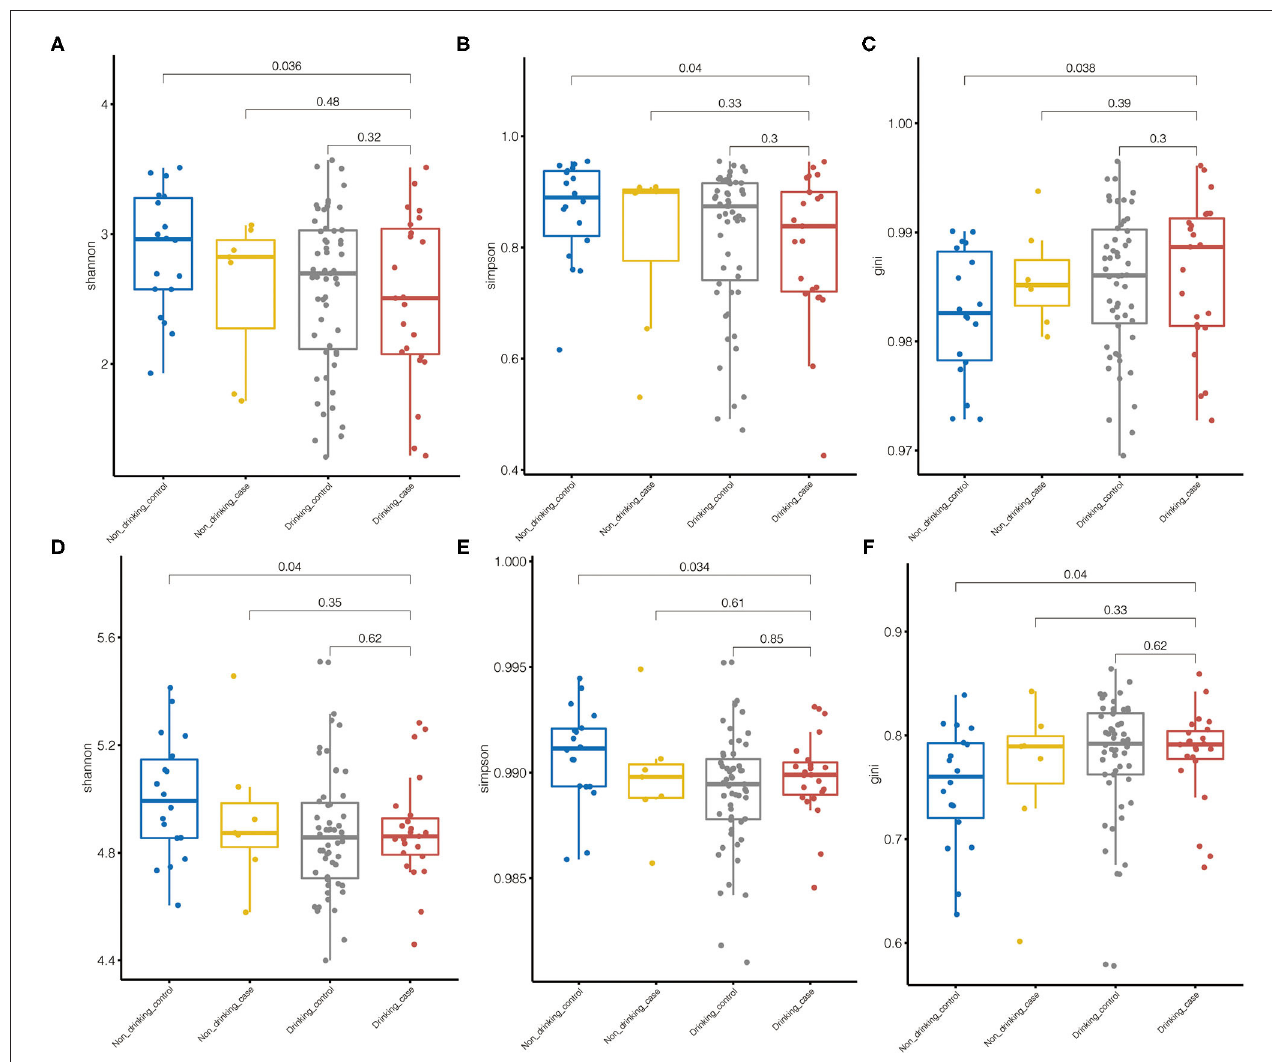
FIGURE 2 | Microbiome diversity. (A–C) Species alpha diversity was estimated by the Shannon index, Simpson index, and Gini index, respectively. (D–F) Pathway alpha diversity was estimated by the Shannon index, the Simpson index, and the Gini index, respectively.